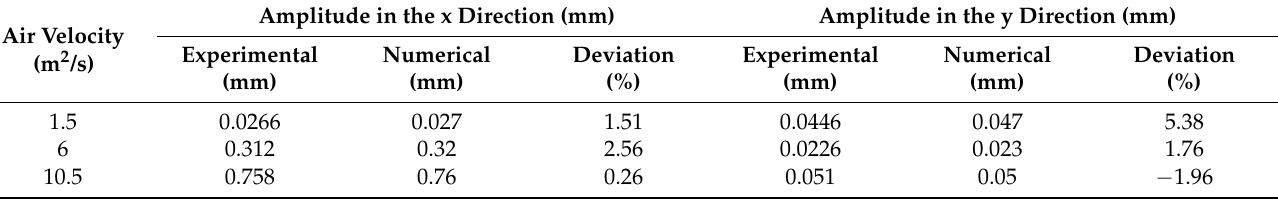
Figure 4. Diagram of hollow fiber membrane flow-induced vibration experimental apparatus. Table 3. Experimental measurements and simulation results of hollow fiber membrane amplitudes in x and y directions at different air velocities.